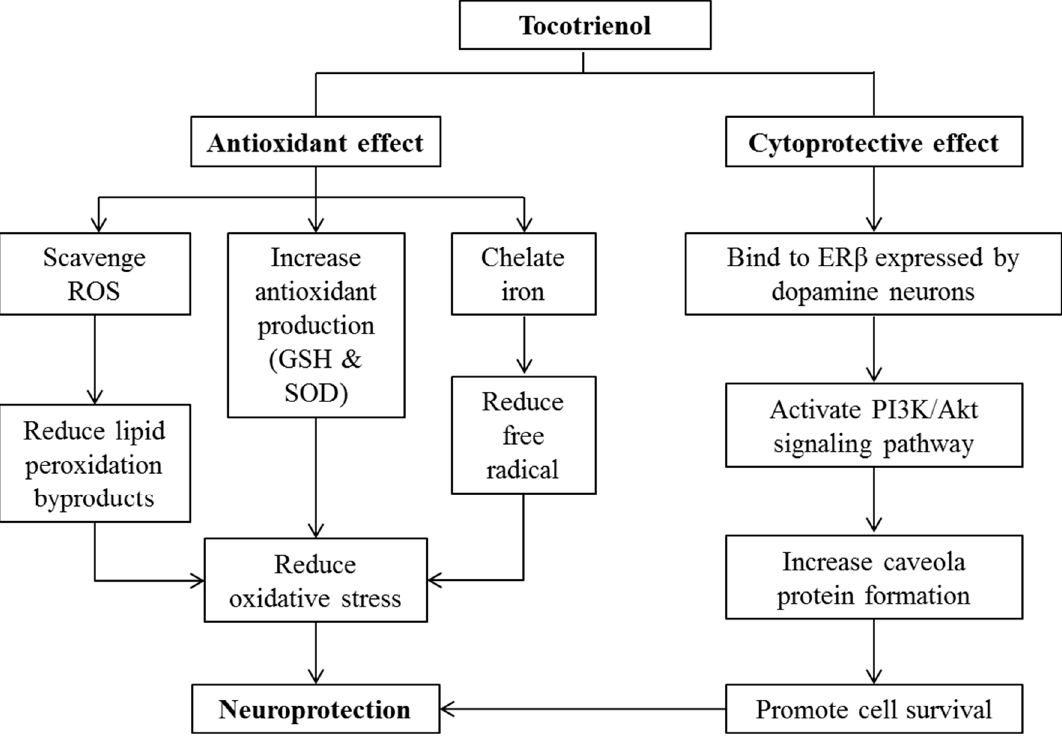
Figure 7. Neuroprotective effect of T3 on Parkinson’s disease.